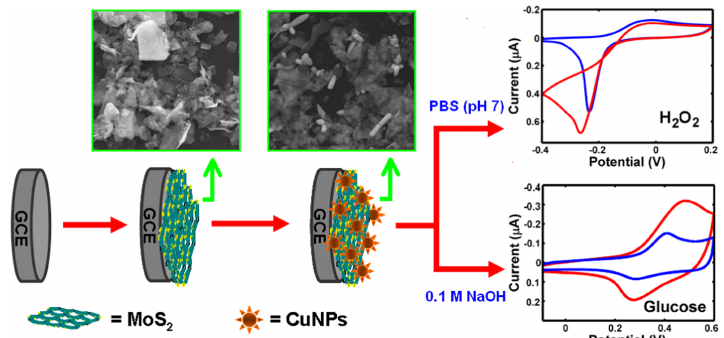
Figure 8. Modified glassy carbon electrode made of multilayer Cu/molybdenum disulfide (CuNFs- MoS 2 /GCE) with 3D nano-flower shape for non-enzymatic sensing. ( Left ) schematic representation of the fabrication of the CuNFs-MoS2/GCE, and ( Right ) possible reaction mechanisms at the electrode during the analysis for H 2 O 2 and glucose. With permission from